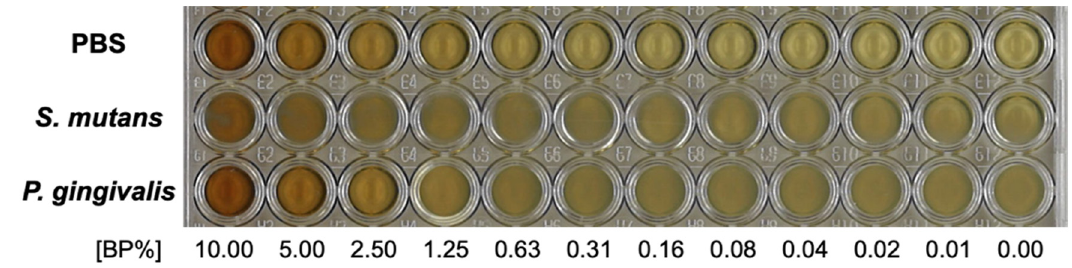
Figure 2. The minimum inhibitory concentrations (MIC) of the bacteria. P. gingivalis showed growth inhibition at a bee pollen concentration ranging from 2.5 to 10%.